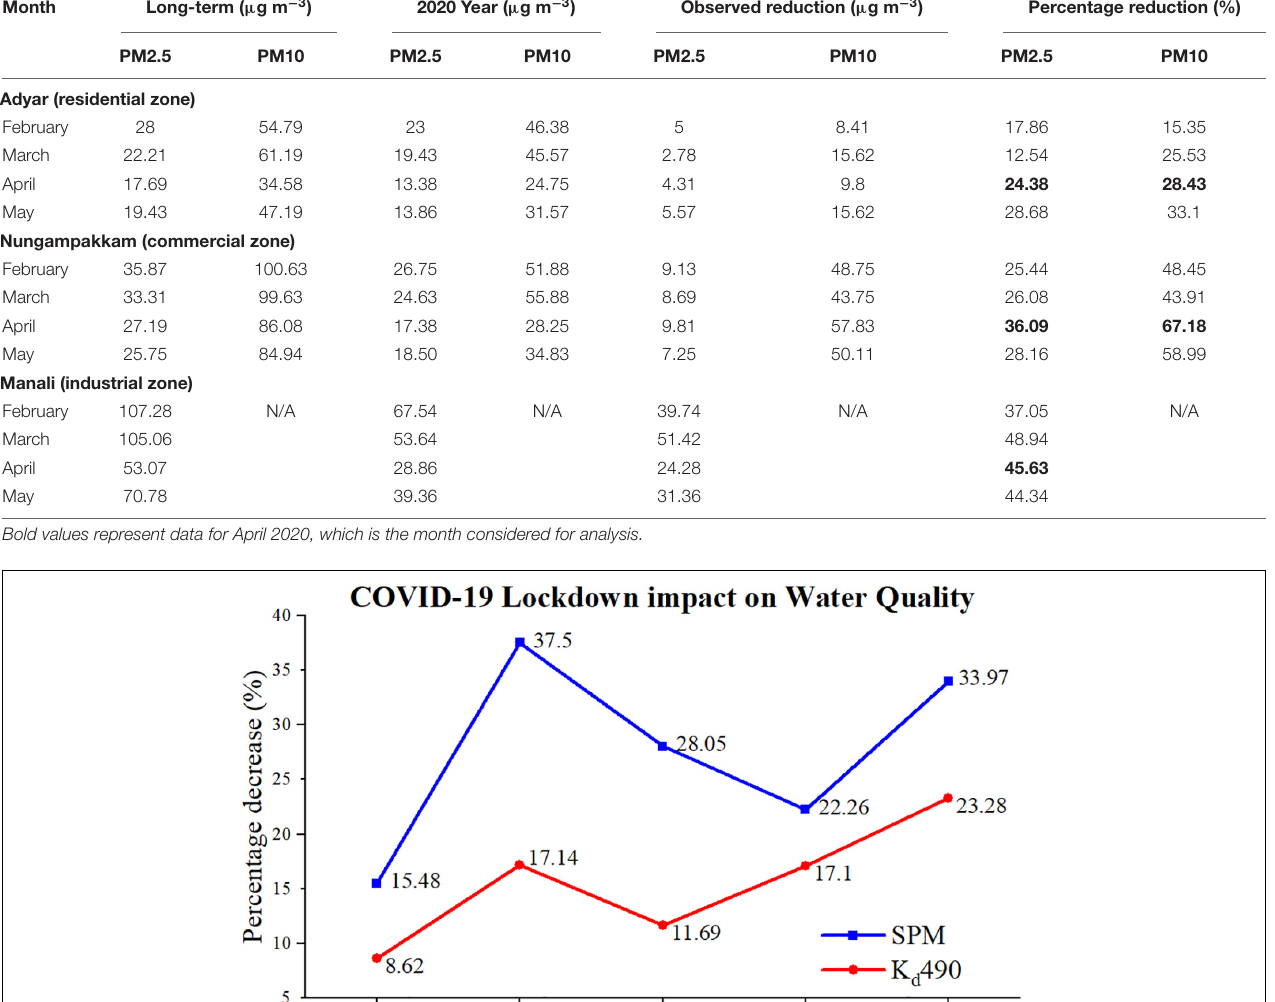
TABLE 3 | Statistical analysis of monthly particulate matter mean data.